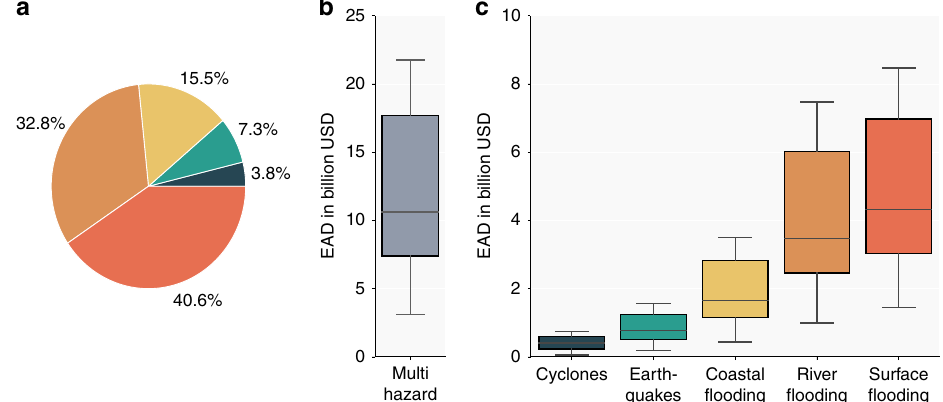
Fig. 3 Total EAD per hazard. Panel a shows the relative distribution of the total EAD to infrastructure assets among the different hazards. Panel b shows the calculated range of total multi-hazard global EAD. Panel c shows the calculated range of the EAD per hazard. The lower and upper whiskers in panels b and c represent, respectively, the lowest 25% of the calculated EAD ’ s and the highest 25% of the calculated EAD ’